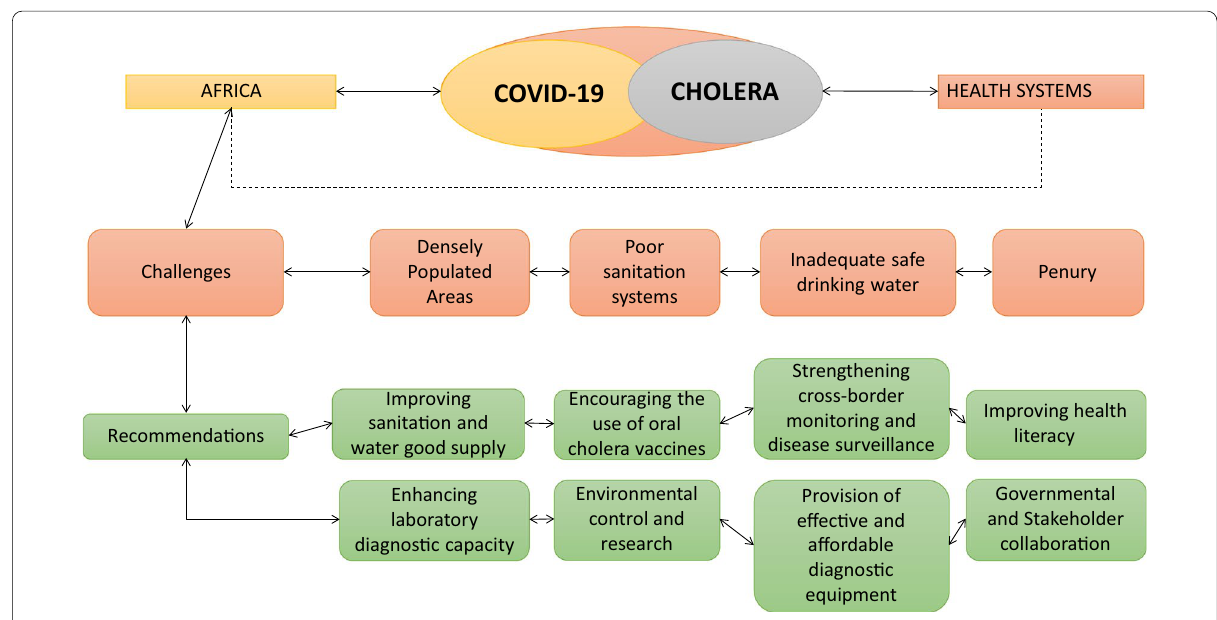
Fig. 1 A summary of challenges, priorities, and recommendations for the restriction of cholera pathogen amid the COVID-19